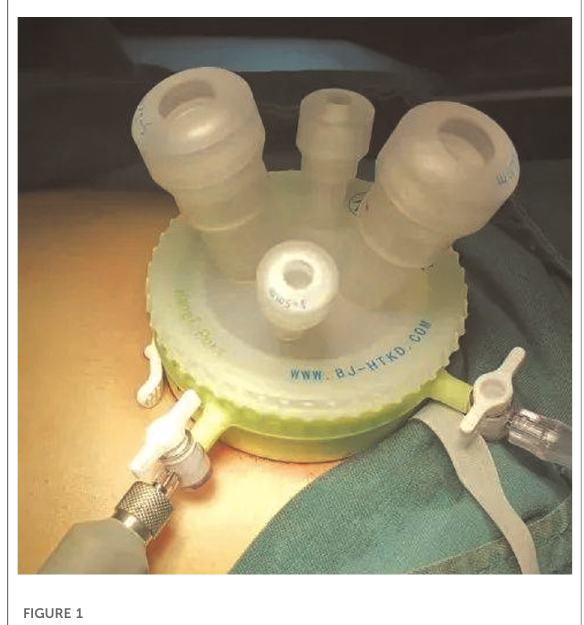
FIGURE 1 Port for laparoendoscopic single-site